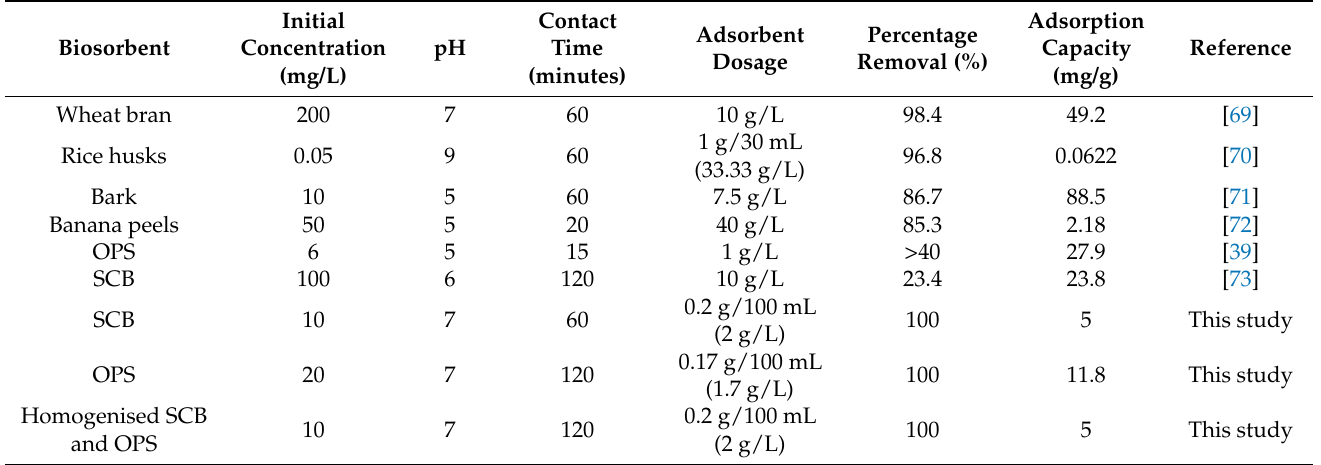
Table 4. Comparison of adsorption of Pb(II) by various cellulose-based agricultural waste adsorbents under optimum experimental conditions.